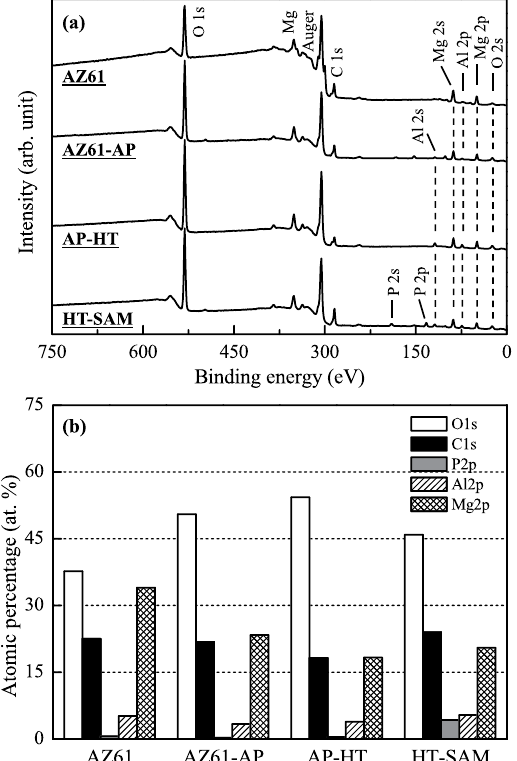
Figure 4. ( a ) XPS analysis results of the survey spectra and ( b ) the atomic percentage (at.%) of surface elements as detected by XPS for the AZ61 Mg alloy, AZ61-AP, AP-HT and HT-SAM.